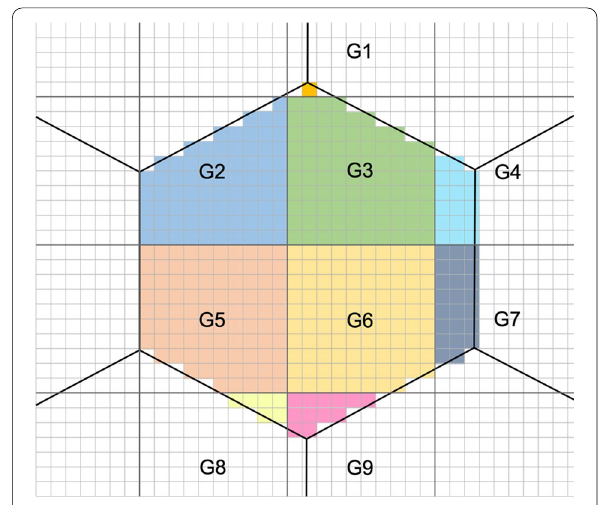
Fig. 1 Illustration of flux conversion from latitude–longitude grids to icosahedral grids. The black line indicates the boundaries of the icosahedral grids, while the dark-gray and light-gray lines represent original and finer latitude–longitude grids, respectively. In the conversion, fluxes in colored areas are allocated to the centered icosahedral